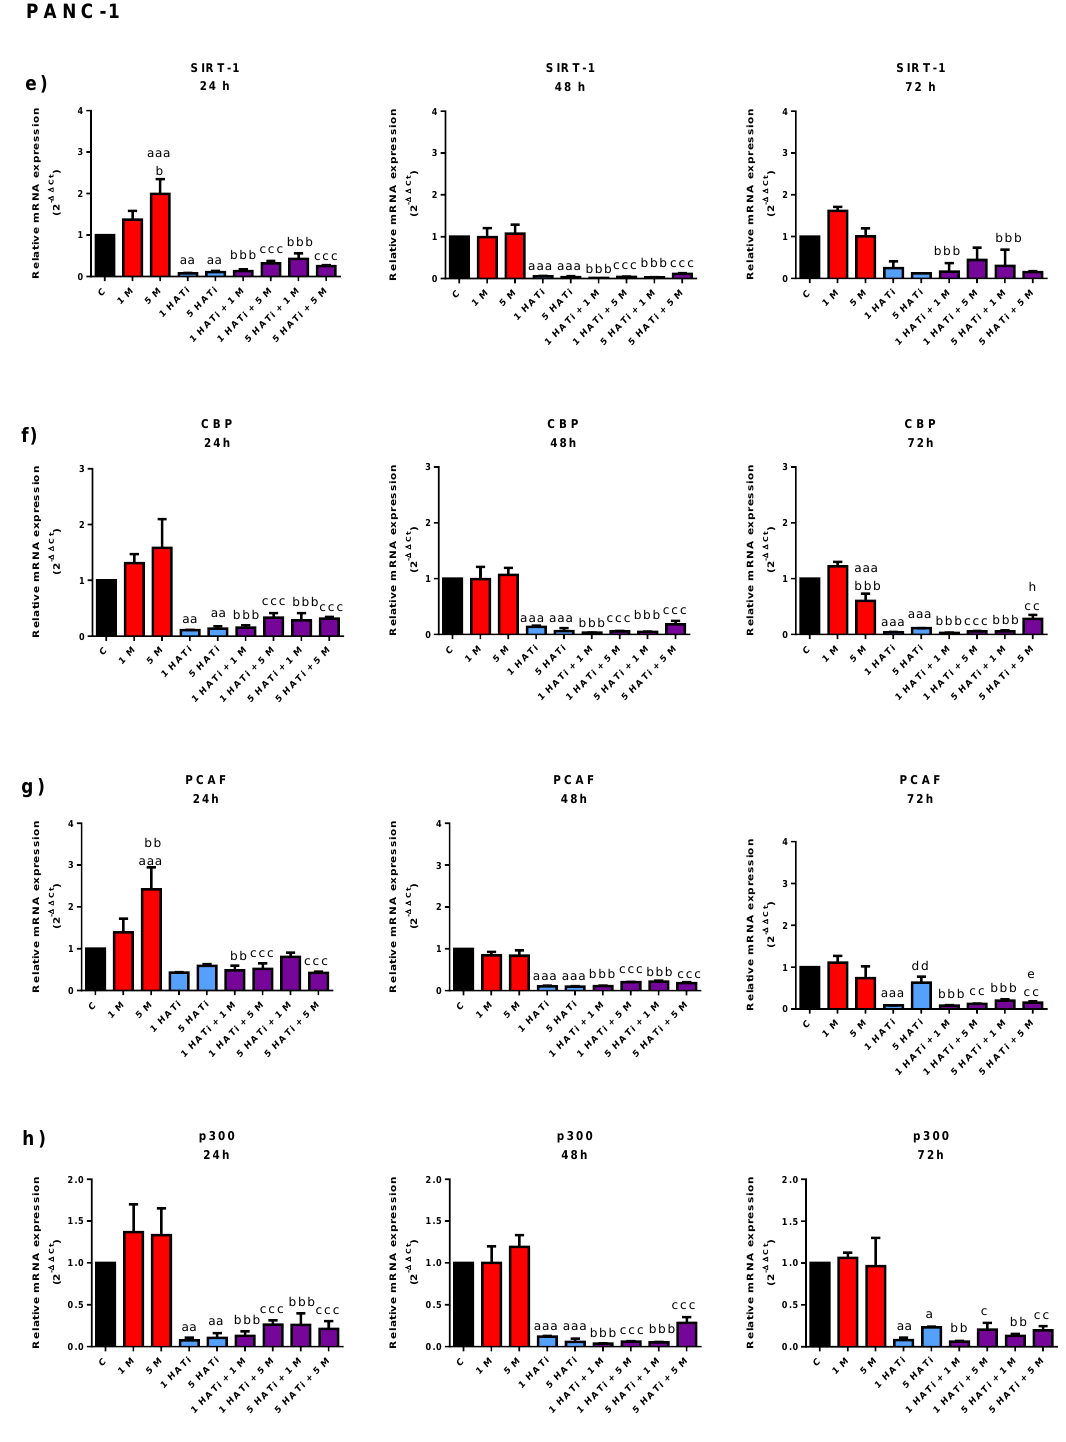
Figure 4. The effect of metformin, HATi, and HATi with metformin on mRNA expression of HDAC (SIRT-1) and HATs (PCAF; p300; and CBP) in 1.2B4 ( a – d ) and PANC-1 ( e – h ) cells. mRNA expression in 1.2B4 ( a – d ) and PANC-1 ( e – h ) cells was determined by qRT-PCR. The cells were treated with metformin (1 and 5 mM; red bars), HATi (1 and 5 µ M; blue bars), and combination of HATi (1 and 5 µ M) with metformin (1 and 5 mM; violet bars) for 24, 48, and 72 h. Data are expressed as the mean ± SD of fold change from three independent experiments in relation to the untreated control, using GAPDH as a reference gene. a p < 0.05; aa p < 0.01; aaa p < 0.001 vs. C; b p < 0.05; bb p < 0.01; bbb p < 0.001 vs. 1 M; c p < 0.05; cc p < 0.01; ccc p < 0.001 vs. 5 M; dd p < 0.01; e p < 0.05; f p < 0.05; h p <